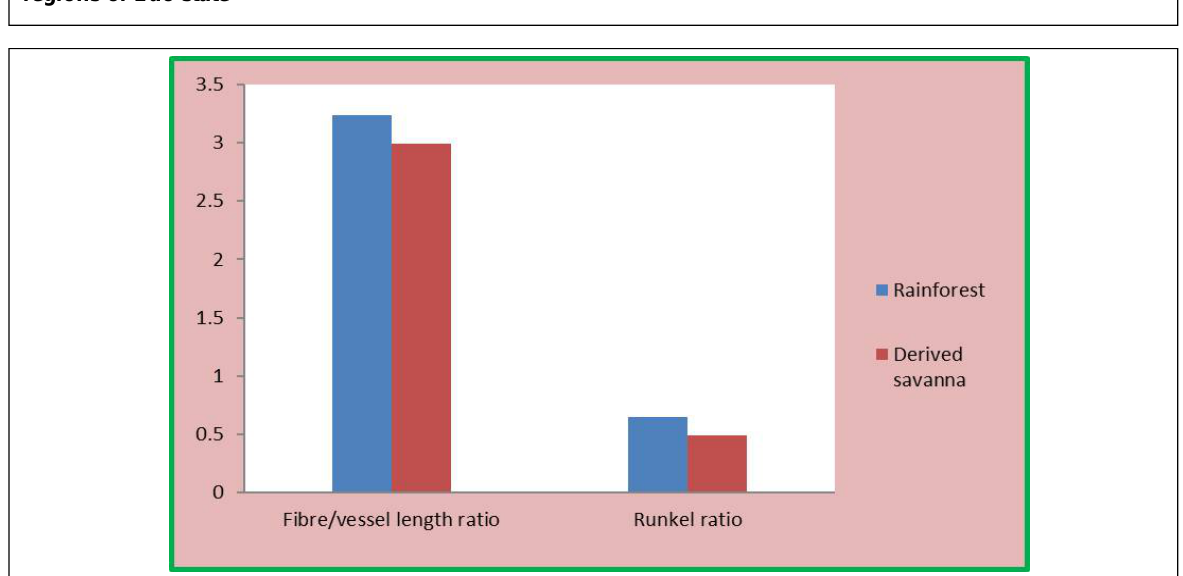
Figure 6: Fiber/vessel length ratio and runkel ratio of L. cupanoides growing in the rainforest and derived savanna regions of Edo